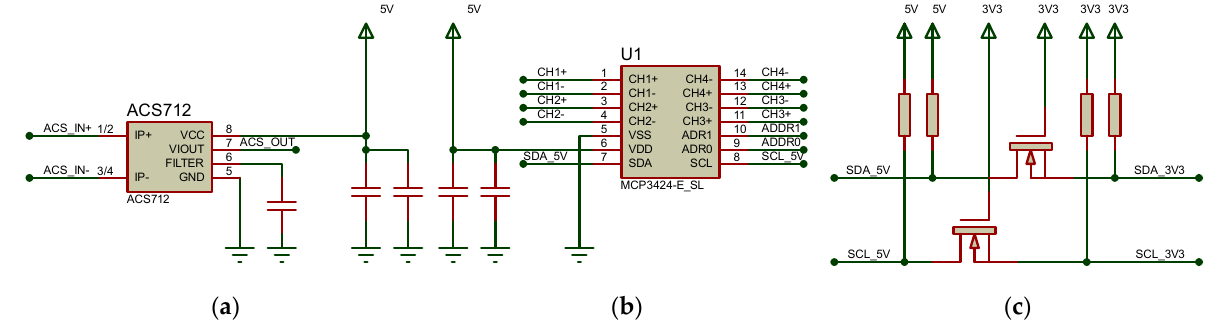
Figure 9. Circuit of sensing block: ( a ) Hall effect current sensor ACS-712; ( b ) Analog to Digital Converter MCP3424; ( c ) Logic level shifter using N-channel MOSFET.